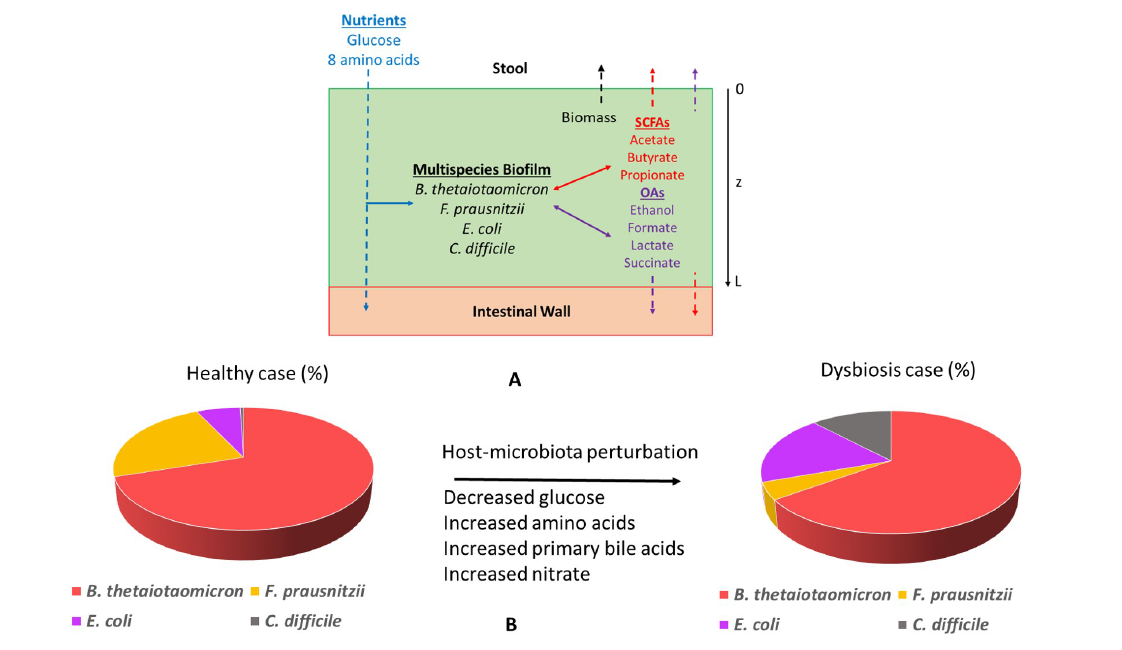
Figure 6. Schematic representation of the in silico gut community. ( A ) The model assumed biofilm attachment to the intestinal wall and described diffusion of glucose, amino acids, short-chain fatty acids, organic acids, ethanol, CO 2 , and species biomass in and/or out of the biofilm along the axial direction z . ( B ) Host-microbiota perturbations were modeled through changes in the bulk concentrations of glucose, amino acids, primary bile acids, and nitrate at the biofilm–stool interface to predict species abundances in healthy and C. difficile -infected